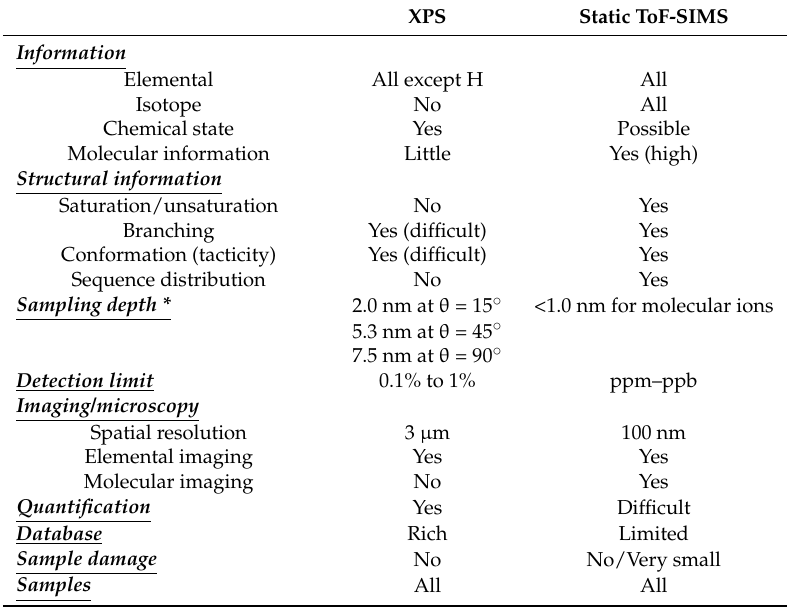
Table 2. Characteristics of X-ray photoelectron spectroscopy (XPS) and static time-of-flight secondary ion mass spectrometry